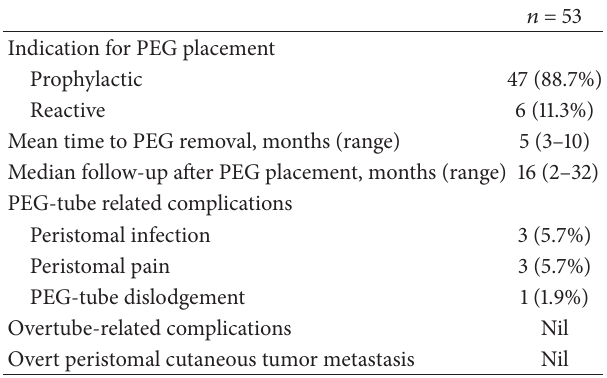
Table 2: Procedural results of 53 patients with HNC undergoing successful overtube-assisted PEG